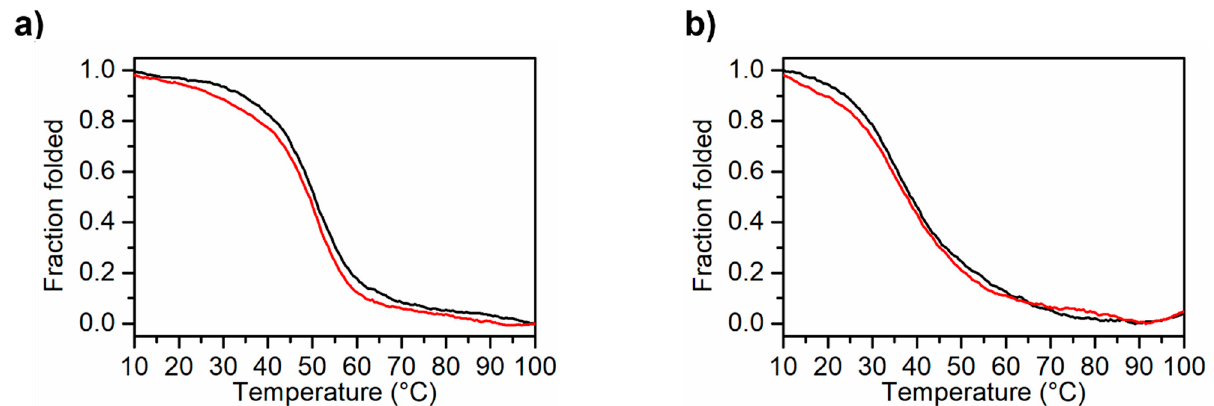
Figure 3. CD melting experiments of MS3 analogues recorded at a scan rate of 0.5 °C min − 1 : CD melting (black line) and cooling (red line) profiles of MS3-33 ( a ) and MS3-17 ( b ) in the Na + buffer (10 mM NaH 2 PO 4 /Na 2 HPO 4 , 90 mM NaCl solution, pH = Table 2. Apparent melting temperature values ( T m ) obtained for the unfolding of MS3-33 and MS3- 17 analogues in comparison with MS3. The error on T m determination is ±1.0 °C.